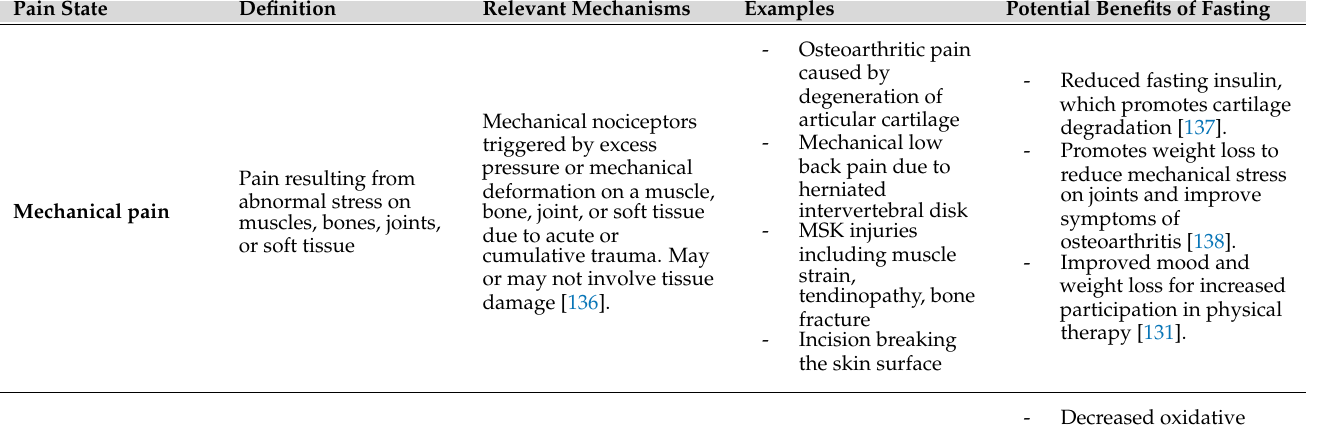
Table 2. Definitions, mechanisms, and potential benefits of